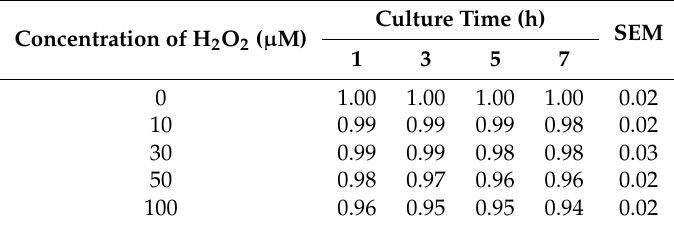
Table 2. The e ff ects of H 2 O 2 treatments on cell survival Table 2. The effects of H 2 O 2 treatments on cell survival rate.